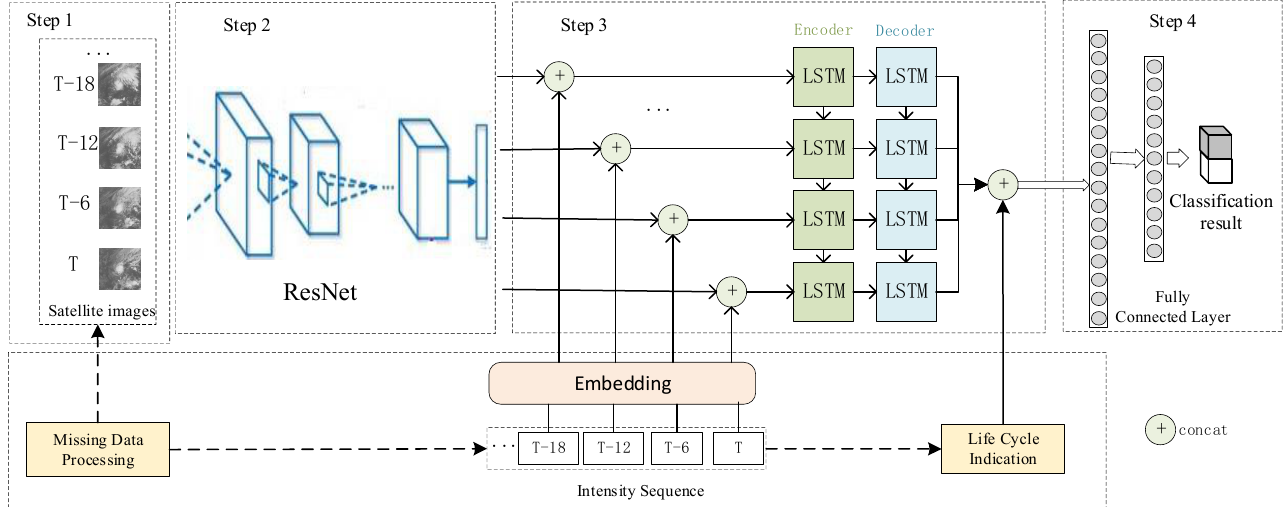
Figure 4. Model technological process diagram. The satellite remote sensing cloud image of No. 1909 Typhoon LEKIMA for four consecutive times, which cover the whole life cycle of the typhoon from its formation to dissipation, is shown in Figure 5a–d. Using the typhoon data of four consecutive moments, with the current moment at 00:00 UTC on 7 August 2019, we extracted the spatio-temporal features from the satellite cloud images and calculated the time series of typhoon intensity. The results showed that the probability of RI occurrence at 12:00 UTC on 7 August 2019 is about 0.83, and the labeled RI index is 1. In the observation, the RI process did occur within 12 h (the wind speed increased from 15 m/s to 38 m/s). Figure Wipha (No. 1907). The satellite cloud images at four consecutive moments, with a current moment at 06:00 UTC on 31 July 2019, were used as the input of the same model to predict